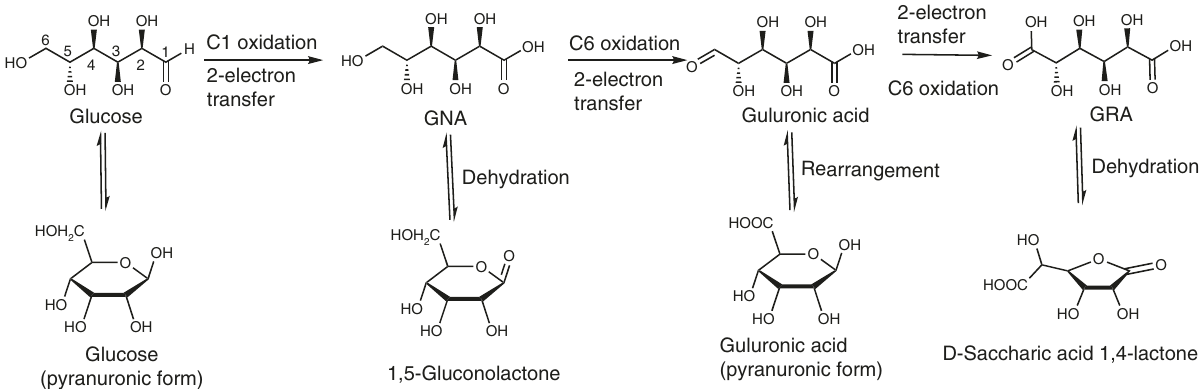
Fig. 5 Possible reaction mechanism. Schematic illustration of the reactions occurring in the electrochemical oxidation of glucose to GRA. together with other electrodes, as shown in the LSV pro fi les in Fig. 7a. Unlike the glucose oxidation, the NiFeN x -NF electrode showed a higher HER activity in 1 M KOH solution than the NiFeO x -NF and NiFe(OH) x -NF electrodes. The overpotentials for reaching current densities of 10 and 100 mA cm − 2 by the NiFeN x -NF electrode were 40.6 and 104 mV, respectively, higher than those of 20% Pt/C catalyst (Supplementary Fig. 23).